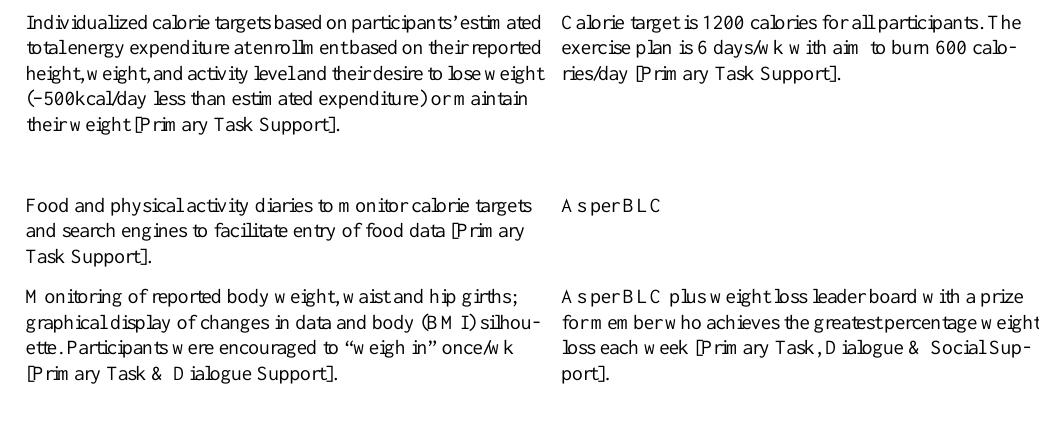
Table 1. Description of the key components of the Biggest Loser Club (BLC) and Shannan Challenge (SC) programs linked to Persuasive Systems Design 4 categories. SCBLCComponent Diet and exercise